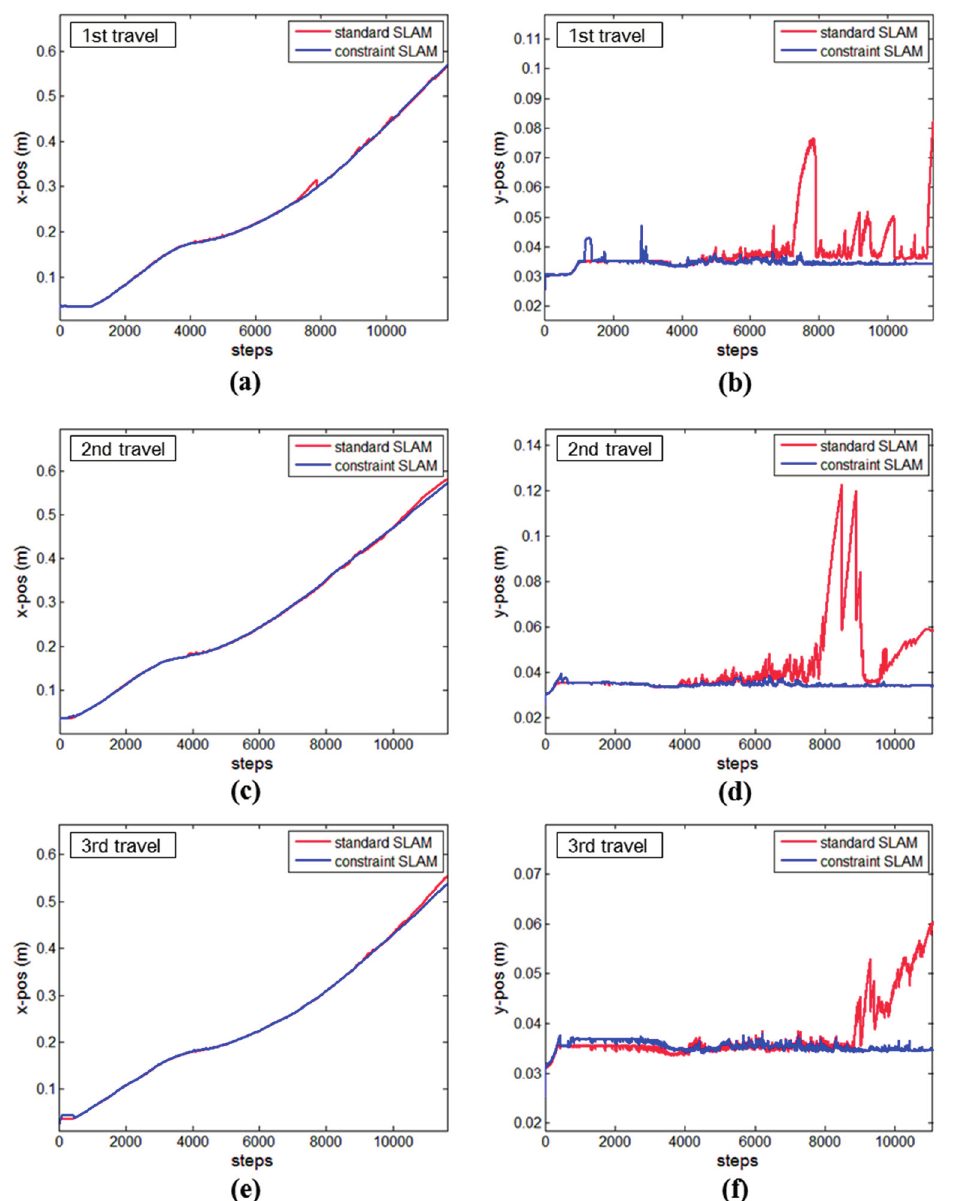
Figure 11. Uncertainty estimates of the corridor test resulting from UKF SLAM without (red graphs) and with (blue graphs) the constrained approach: sideward direction ( a , c , e ) and forward direction ( b , d , f